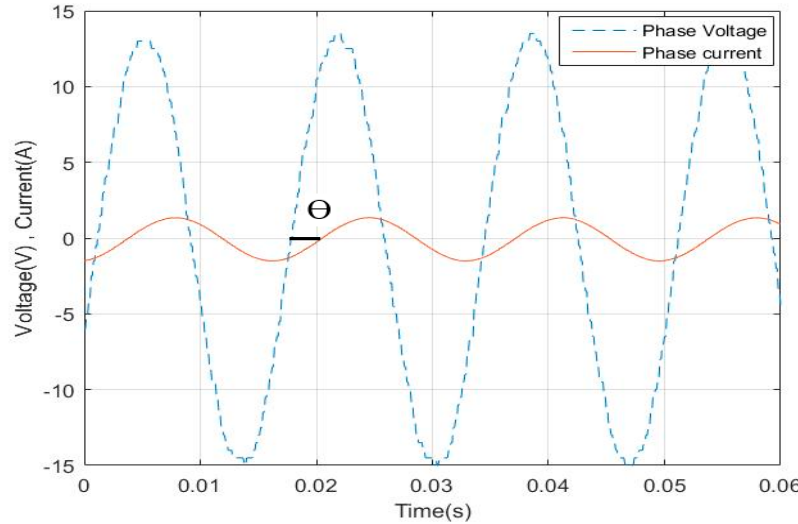
Figure 15. Voltage and current waveforms using CASSY unit.